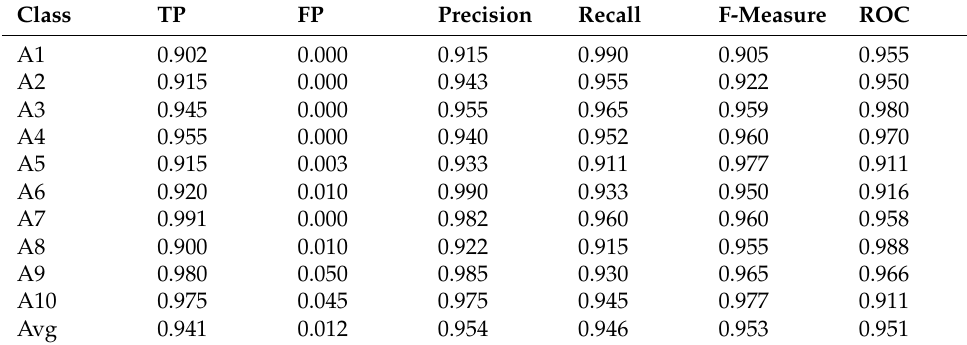
Table 11. NN classification performance.